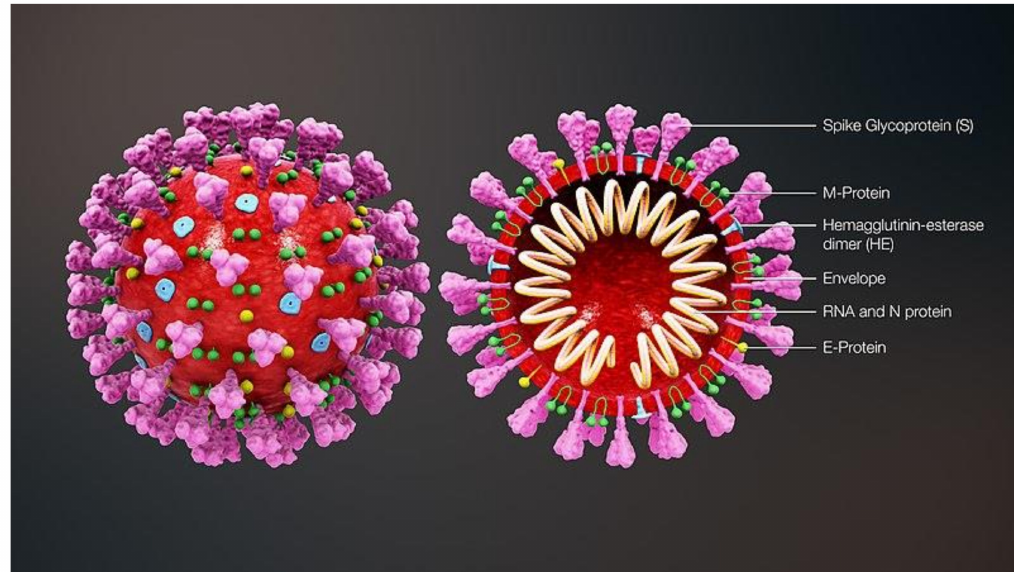
Figure 1. SARS-CoV-2 structure. The key structural proteins of the virus are listed. The spike (S) protein mediates attachment and fusion. The membrane (M) and envelope (E) proteins provide structure to the virion. The nucleocapsid (N) packages the viral single-stranded RNA